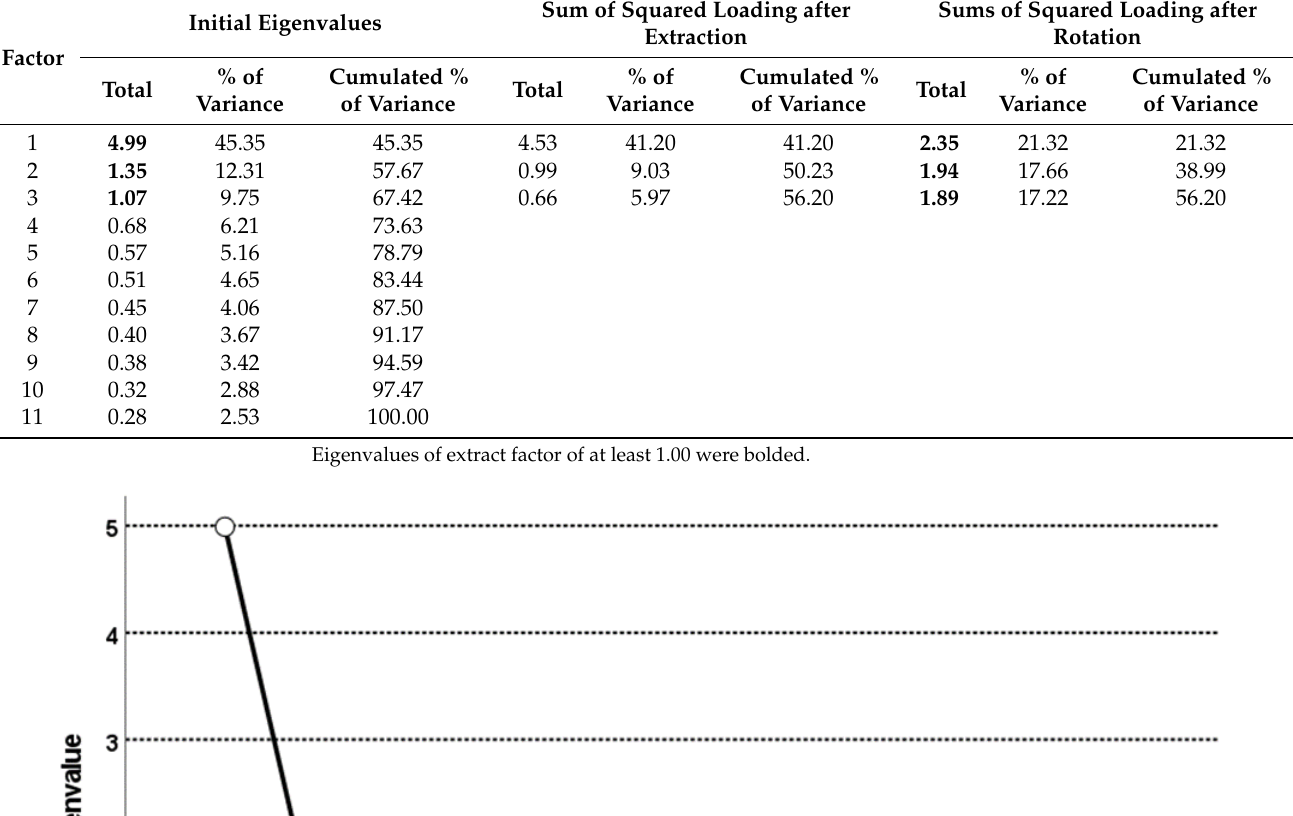
Table 3. Total variance explained by the three-factor latent structure of the scale.